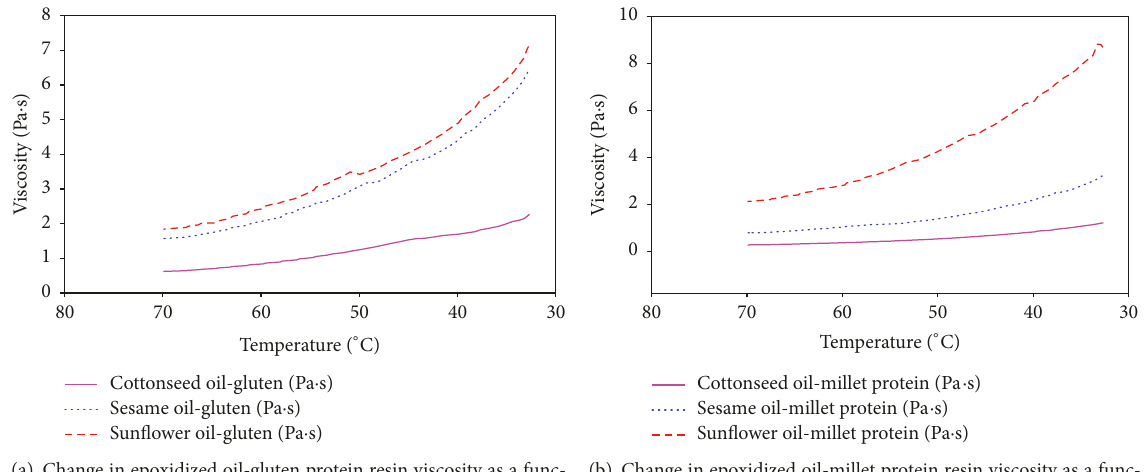
(b) Change in epoxidized oil-millet protein resin viscosity as a func- tion of temperature ramp down from 70 ∘ C to 30 ∘